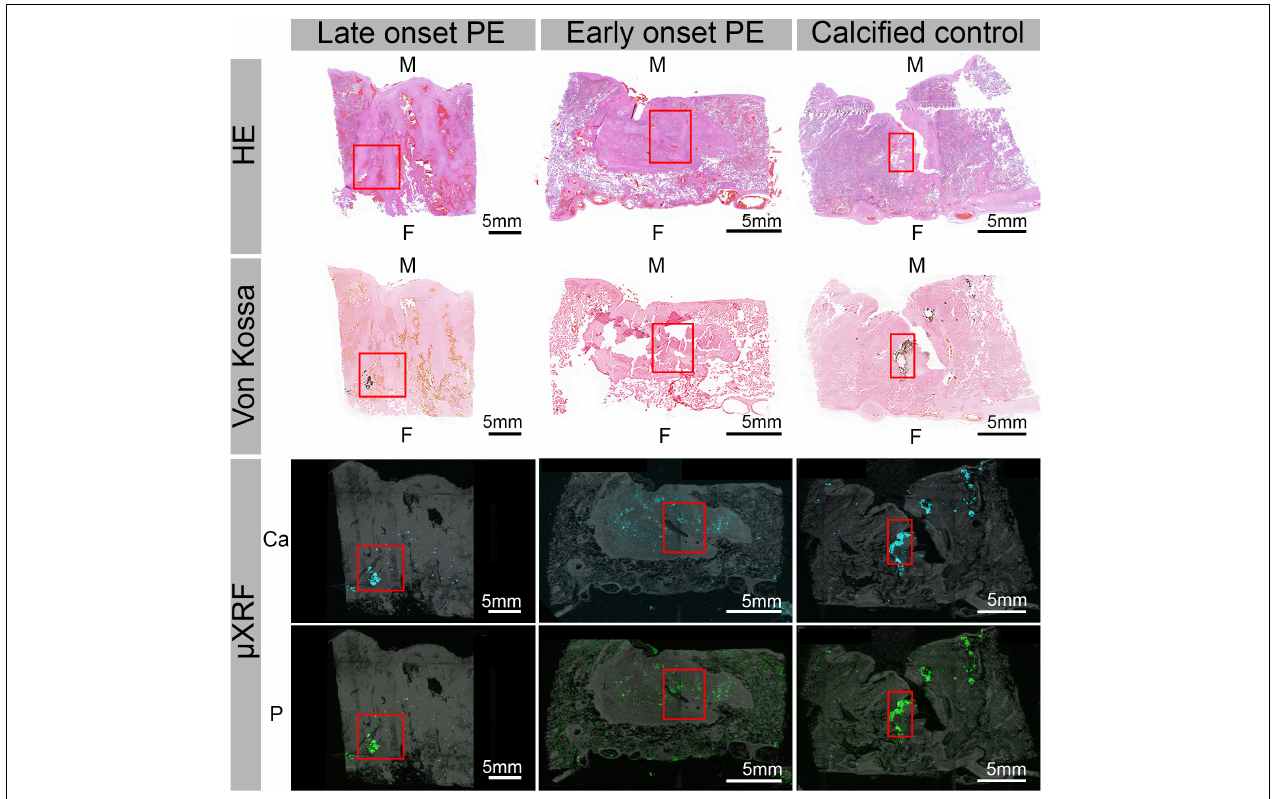
FIGURE 4 | Hematoxylin eosin (HE) and von Kossa-stained histological sections as well as corresponding µ -X-ray fluorescence spectroscopy ( µ XRF) elemental maps for Ca and P obtained from three representative placentae. The µ XRF maps were each overlayed with the corresponding camera image of the respective tissue for better visibility. From left to right: late onset PE, early onset PE and calcified control placenta. The letter M indicates the maternal and F the fetal side. Red boxes indicate highly calcified